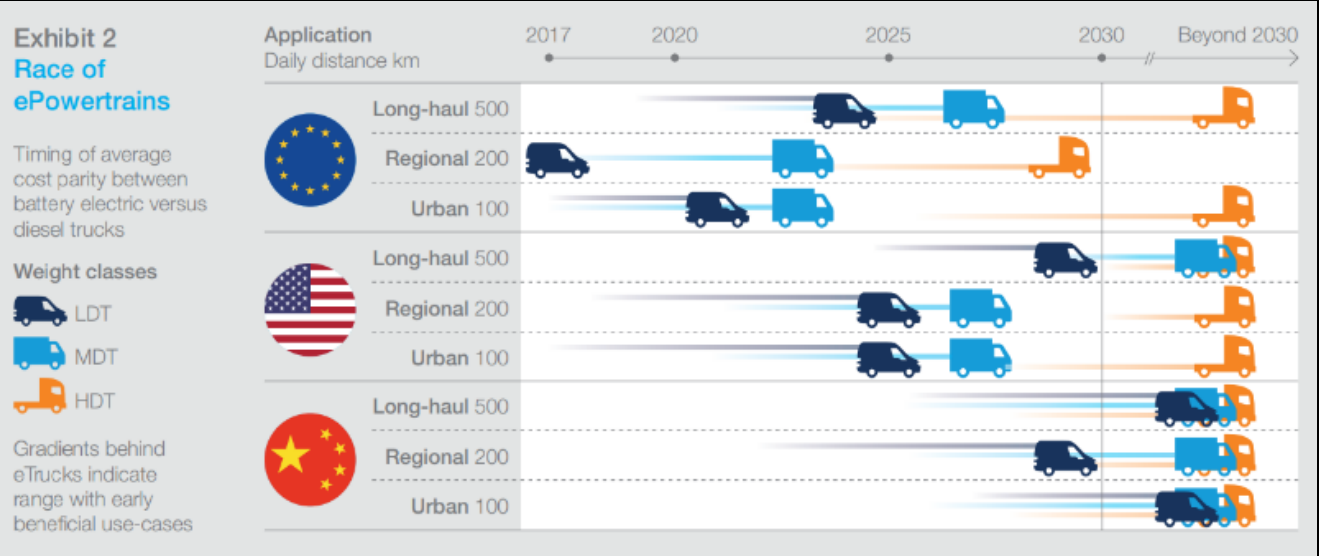
Figure 1: Race of